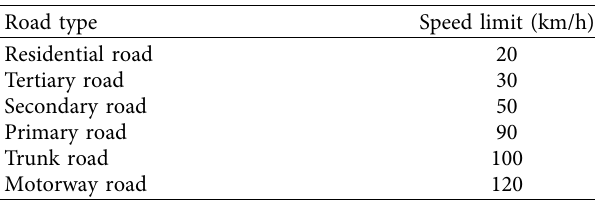
Table 3: Speed limit of the roads.